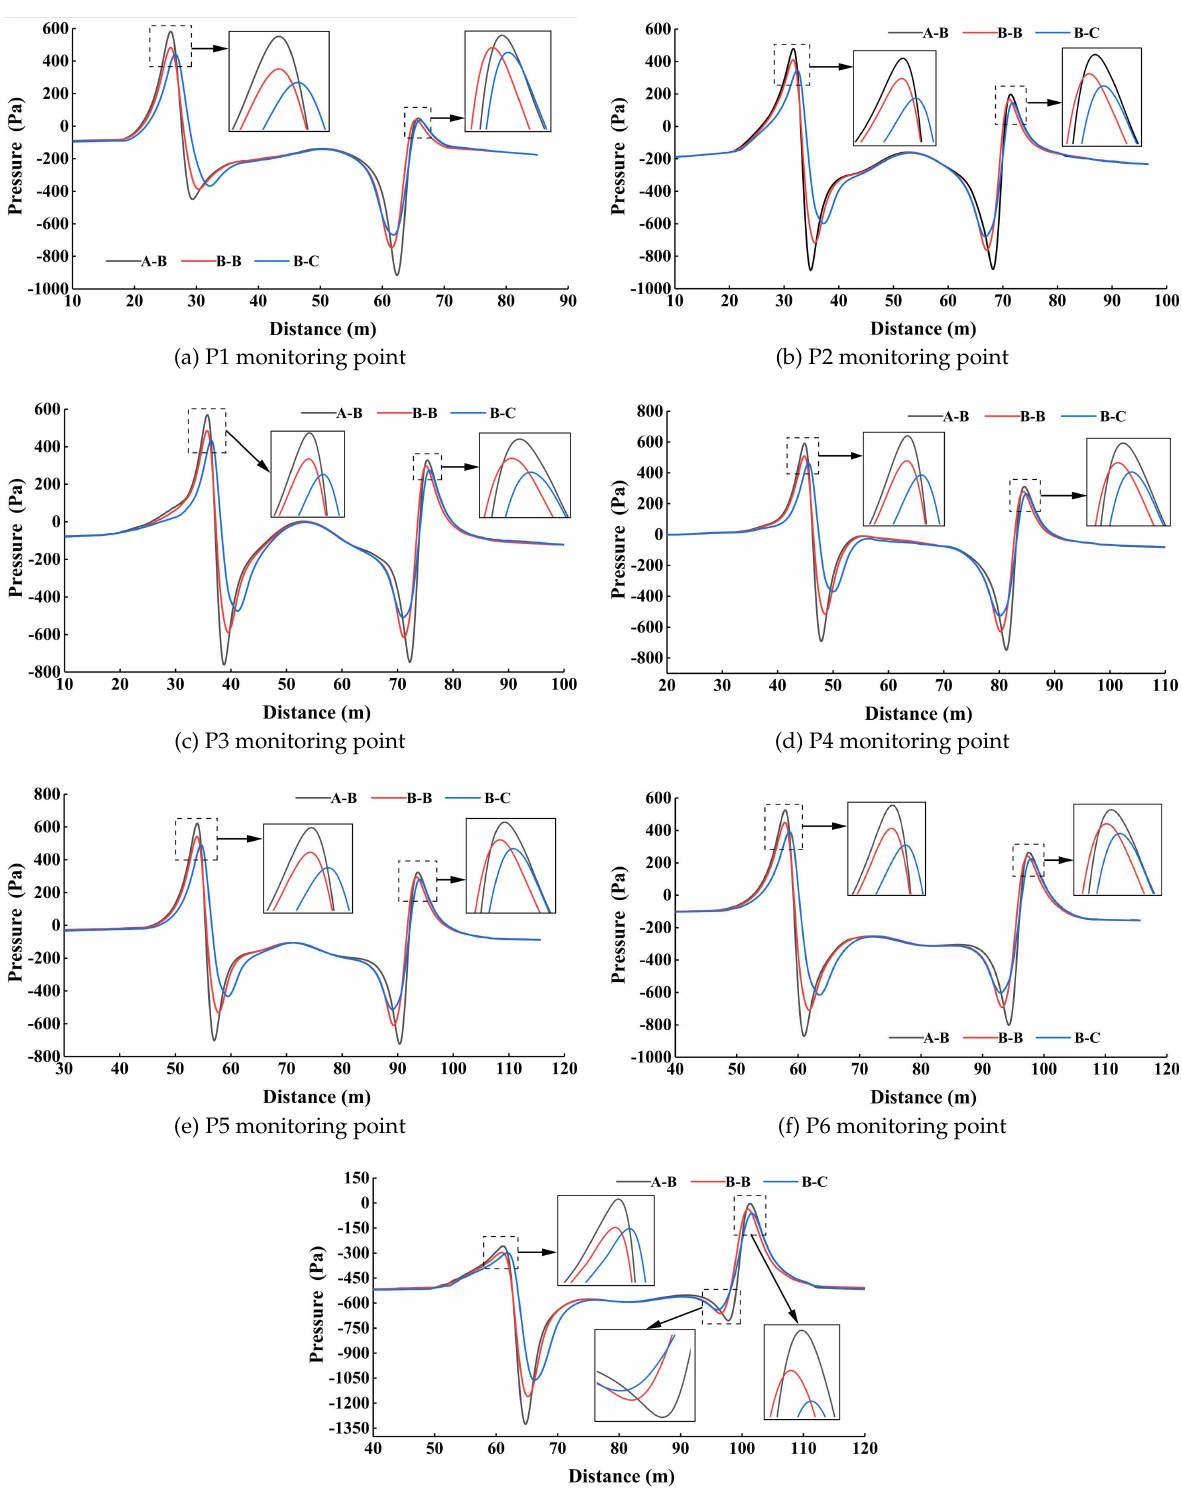
Fig. 9. Pressure curves of monitoring points on the observing